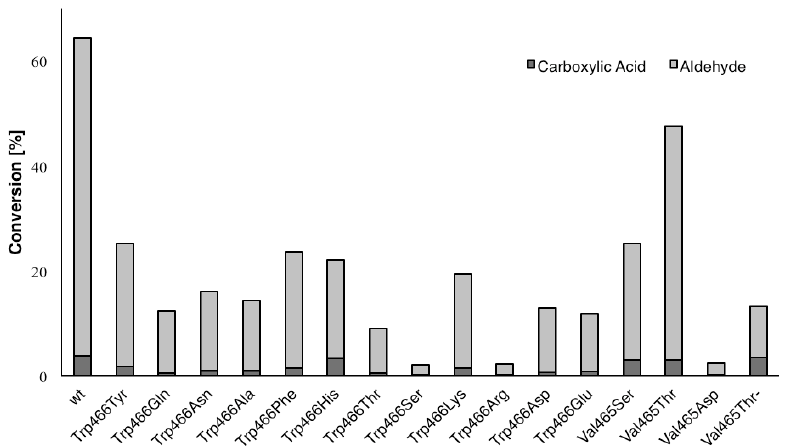
Figure 3. Oxidation of 4-nitrobenzyl alcohol ( 5a ) (25 mM) to 4-nitrobenzaldehyde ( 5b ) and 4-nitrobenzoic acid ( 5c ) by HMFO variants (0.7 µM) in sodium phosphate buffer (100 mM, pH 7.0) at 30 °C with atmospheric oxygen in presence of catalase after 2 h (HPLC). Table 1. Enhanced carboxylic acid formation ( 5c ) from 5a with HMFO variants. Variant Ratio (%) a